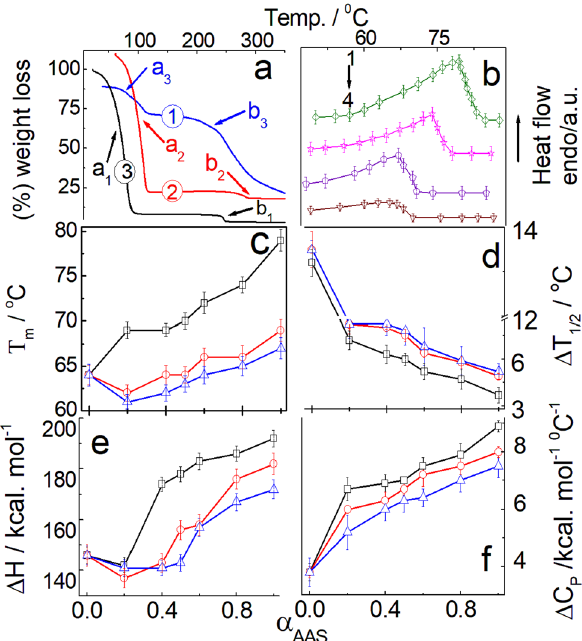
Figure 2. ( a ) TGA of AAS + HTAB (100 mM, 40/60, M/M) gel. Systems: 1, C 12 GluNa 2 + HTAB; 2, C 12 AspNa 2 + HTAB and 3, C 12 MalNa 2 + HTAB. a 1 , b 1 , a 2 , b 2 , a 3 , and b 3 represent different phase transitions. ( b ) DSC of C 12 MalNa 2 + HTAB mixture at different mole% of C 12 MalNa 2 : 1, 80; 2, 60; 3, 40 and 4, 0. Variations of ( c ) chain melting temperature ( T m ); ( d ) half peak height (Δ T 1/2 ); ( e ) enthalpy change (Δ H ) and ( f ) heat capacity change (Δ C p ) with the mole fraction of AAS ( α AAS ). The line colours in panels ( c – f ) represent similar surfactant composition as in panel ( a ). Scan rate: 2 °C min −1